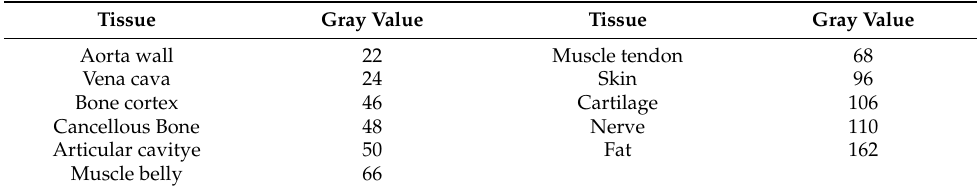
Table A1. Tissue’s Gray Values..